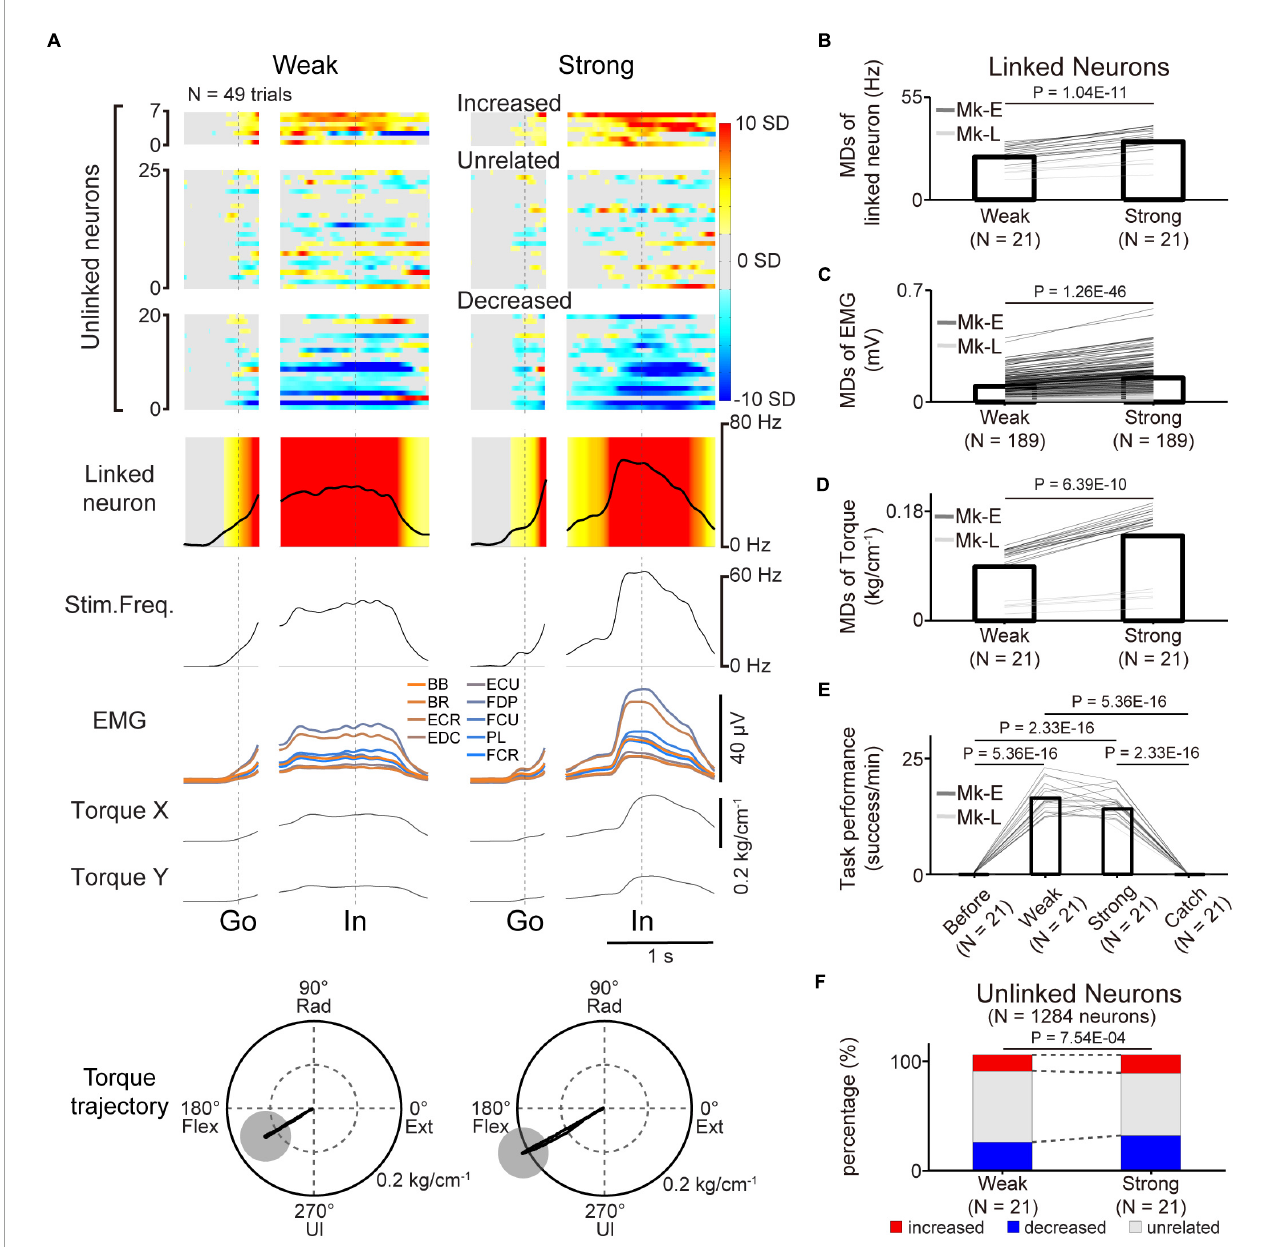
FIGURE7 Volitional control of a paralyzed forearm during a three-graded torque-tracking task with the corticospinal interface. (A) Examples of the average M1 firing rate (1st and 2nd rows), stimulus frequency (3rd row), EMG of the forelimb (4th row), and wrist torque (5th and 6th rows) in the weak torque trials (left panel) or strong torque trials (right panel) for a representative session. Heatmap indicates Z -scored firing rates of unlinked and linked neurons. Plots are aligned when the peripheral target appeared (“Go”) or when the cursor entered the peripheral target (“In”), indicated by the vertical dotted lines. Torque trajectories are two-dimensional plots of the average wrist torque in the weak torque trials (left) and strong torque trials (right). The gray circles represent the targets of peripheral wrist torque. (B–F) Change of M1 neurons, EMG, wrist torque, and task performance during the three-graded torque-tracking task [ N = 21 sessions in the weak and strong torque trials (Monkey E, N = 16 sessions; Monkey L, N = 5 sessions)]. Black horizontal lines represent significant differences. Bars in panels (B–F) indicate mean values. (B) According to the increase of the required torque, the MDs of the linked neurons increased ( P < 0.05 by paired t -test). (C,D) Statistical analysis: P < 0.05 by paired t -test. (E) Task performance during the corticospinal interface trials was significantly higher than before the corticospinal interface trials and during the catch trials ( P < 8.33 × 10 − 3 by paired t -test with Bonferroni’s correction for post hoc multiple comparisons). (F) The percentage of increased and decreased neurons was increased in the strong torque trials ( P < 0.05 by Chi-squared test).